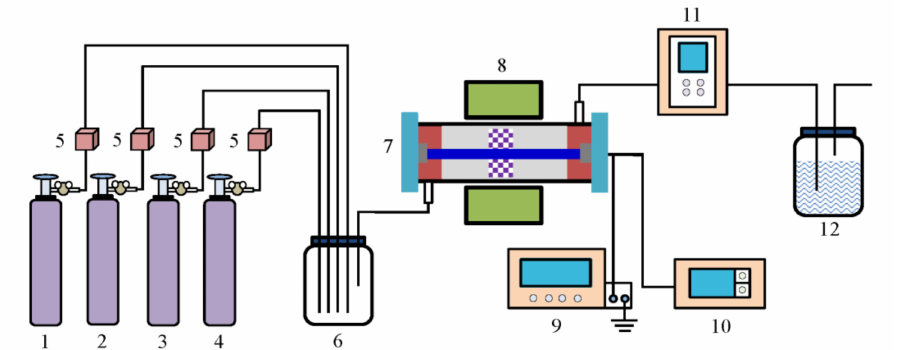
Figure 12. Schematic of the dielectric barrier discharge (DBD) plasma experiment. 1 Ar, 2 O 2 , 3 NO, 4 NH 3 , 5 Mass flow controller, 6 Bu ff er tank, 7 Plasma reactor, 8 Resistance furnace, 9 Power supply, 10 Digital oscilloscope, 11 Gas analyzer, and 12 Alkali absorption.